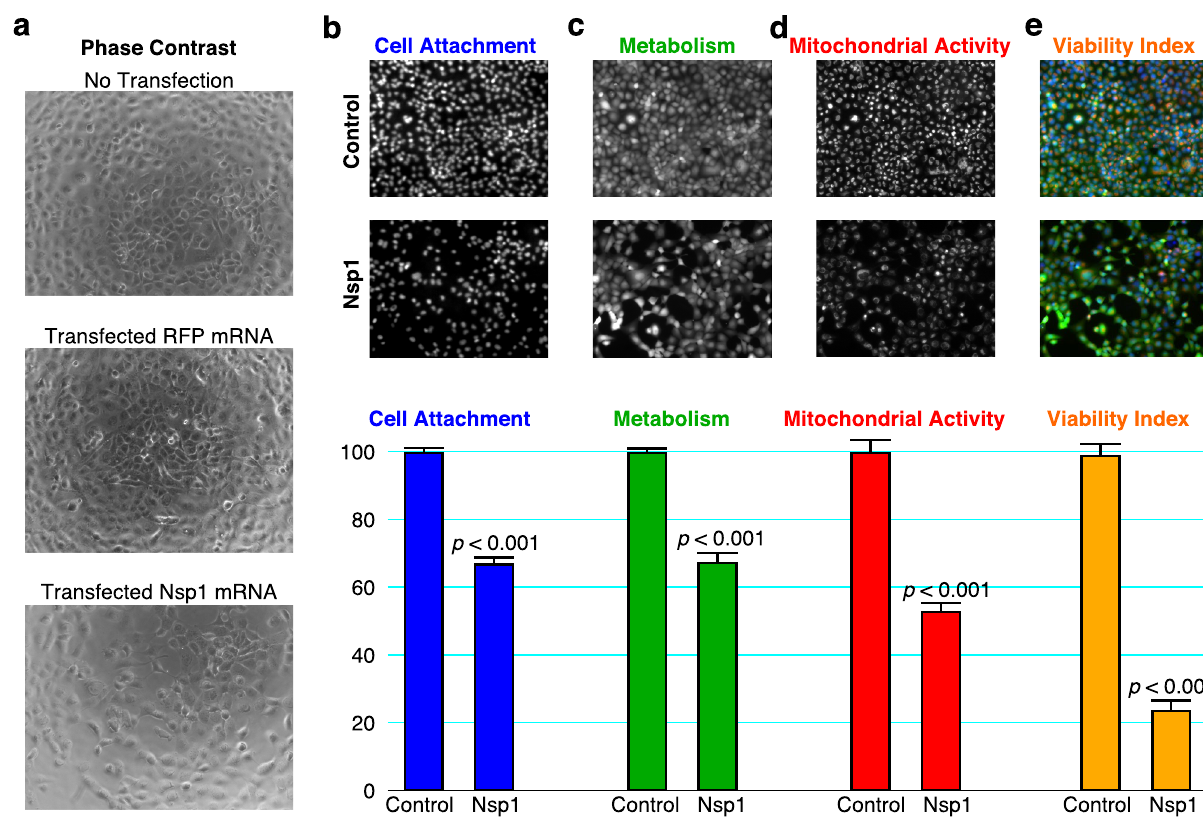
Figure 1. Quantitation of the cytopathic effects of Nsp1 in H1299 cells. H1299 cells were transfected with Nsp1 mRNA in 96-well plates as described in “Methods” section. ( a ) Phase contrast images of non-transfected cells, and cells transfected with Tag-Red Fluorescent Protein (RFP) mRNA as a control or Nsp1 mRNA. Both RFP and Nsp1 mRNAs were flanked by viral UTRs, and cells were transfected under identical conditions on the same plate. Control (non-transfected) and Nsp1-transfected cells were stained with ( b ) Hoescht 33,342 dye as a measure of cell attachment; ( c ) Calcein-AM, as a measure of vitality or metabolic diversion; ( d )